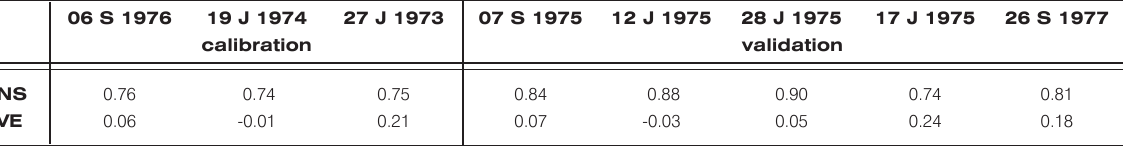
Table 2. Model performance coefficients for calibration/validation